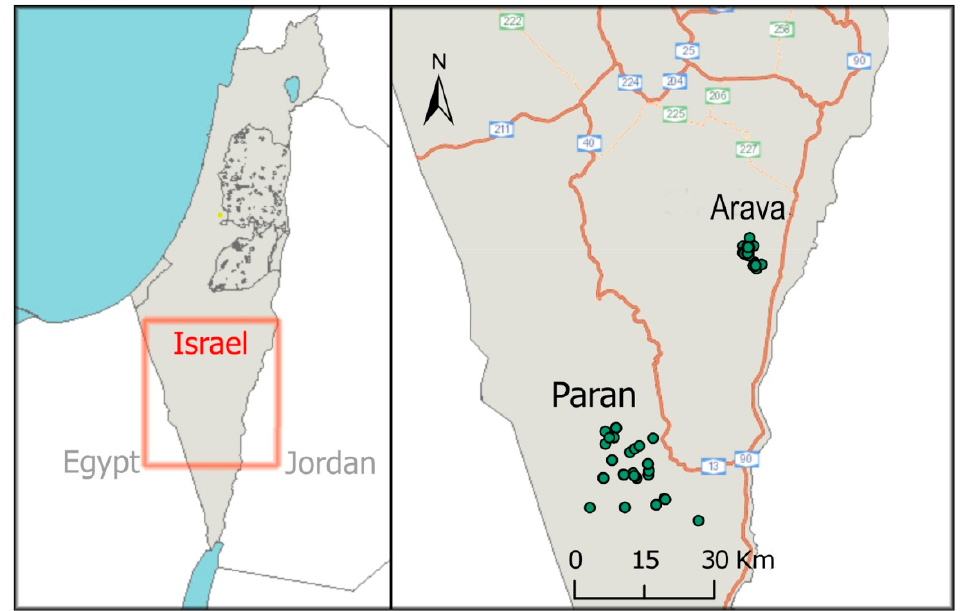
Figure 1. A map of Israel showing the release sites of the Arava and Paran. All Acacia trees are evergreen but shed some of their leaves in winter, and in the Israeli dry season behave as in the African wet season, bearing their fruit in summer [24]. However, there are major differences in the value of their fruits as forage. In A. raddiana and A. tortilis full seed pods begin to shed in June and July, respectively, until August, whereas the fruit of A. pachyceras sheds its seeds from October to December, and the empty pods fall down gradually. Apart from Acacias, the bushes Ochradenus baccatus (Delile) and saltbush ( Atriplex halimus L.) anecdotally represent important sources of browse. Germination of annuals occurs typically in December but is greatly affected by the timing and amounts of precipitation.